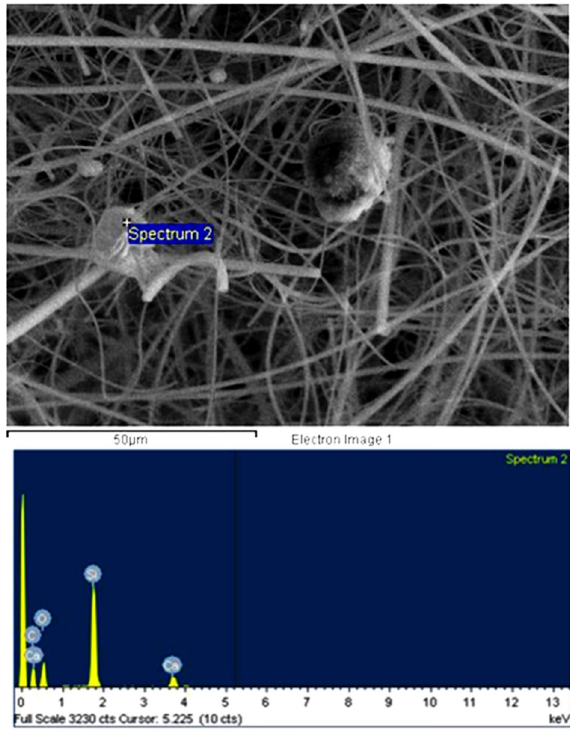
Figure 3. SEM micrograph and EDS spectrum of the mineral phase, corresponding to Calcite (CaCO